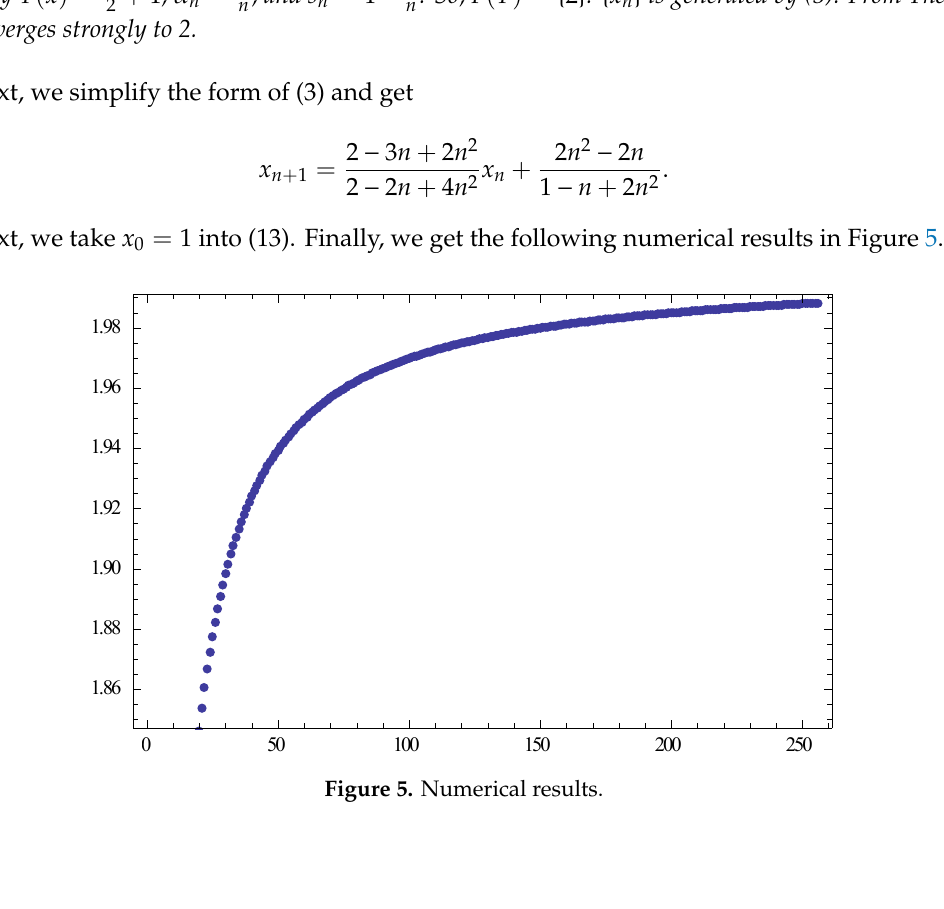
Figure 4. Numerical results.